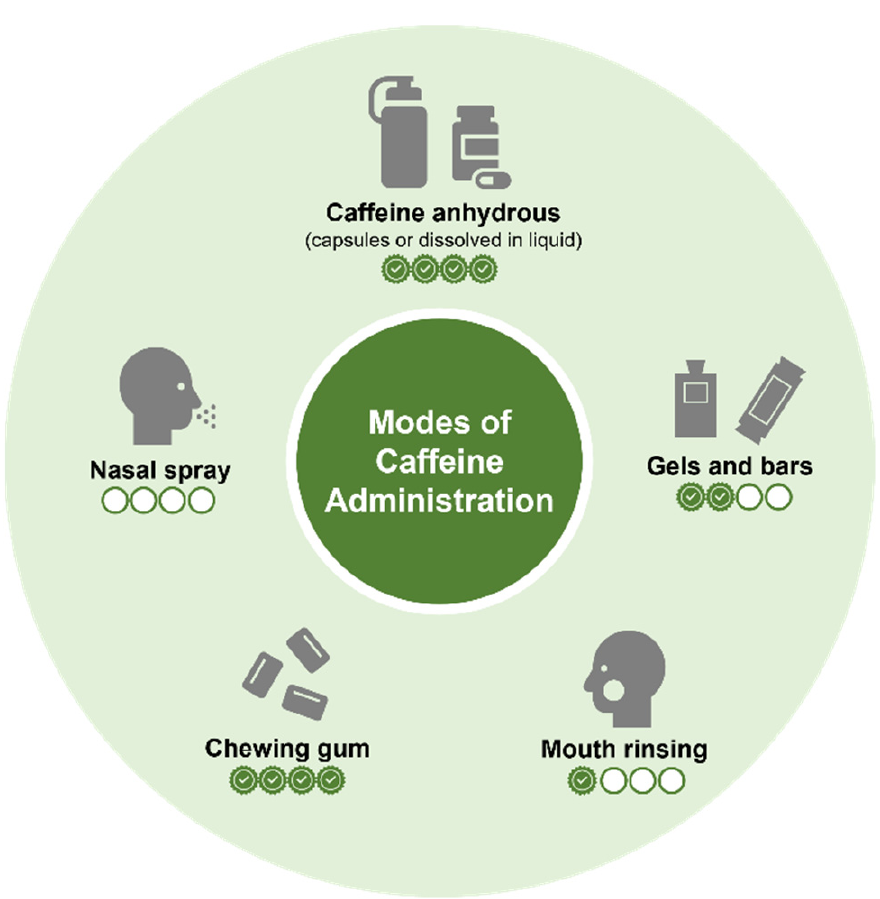
Figure 2. Summary of different modes of caffeine administration. [Symbols represent current level of supporting evidence based on expert opinion of the authors].